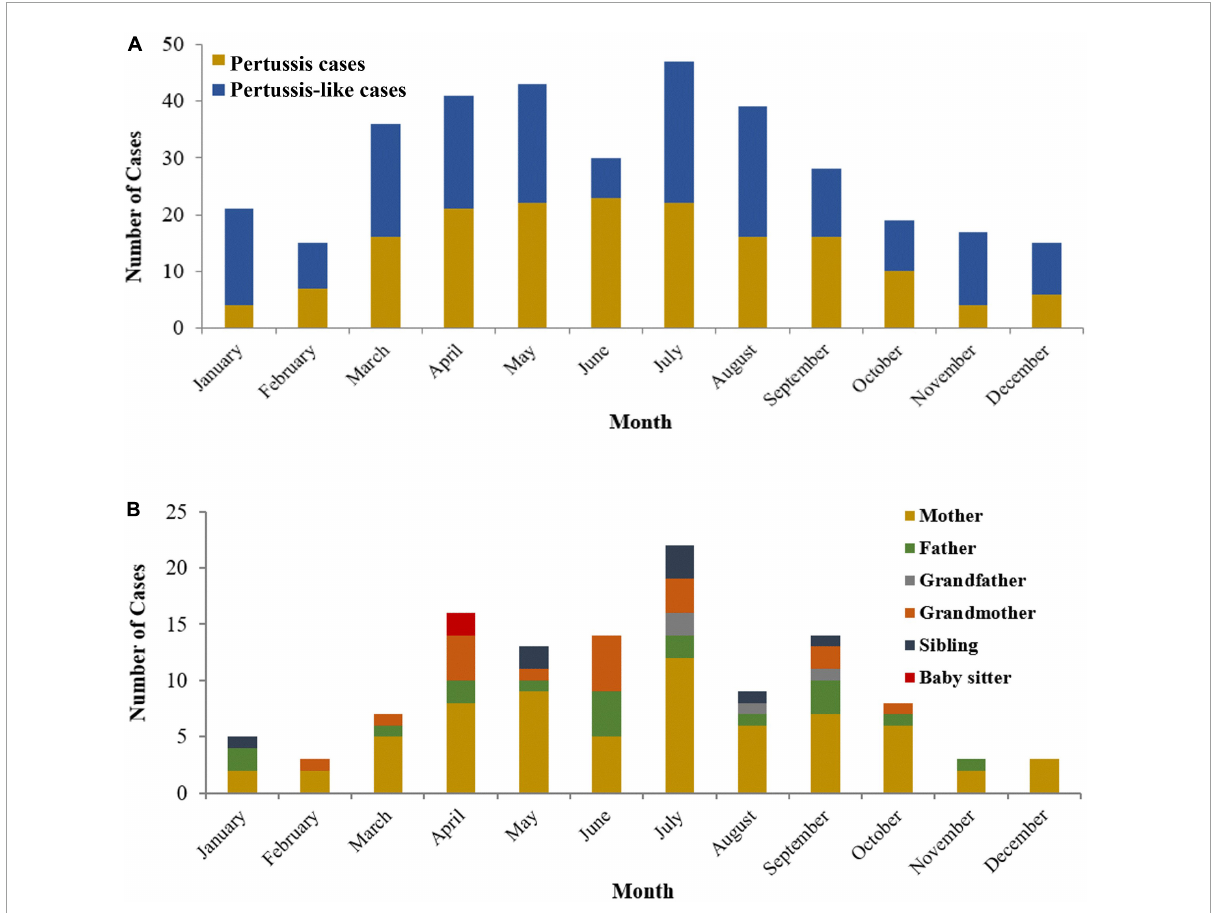
FIGURE2 The distribution of pertussis cases (A) and positive household close-contacts (B) between 2018 and